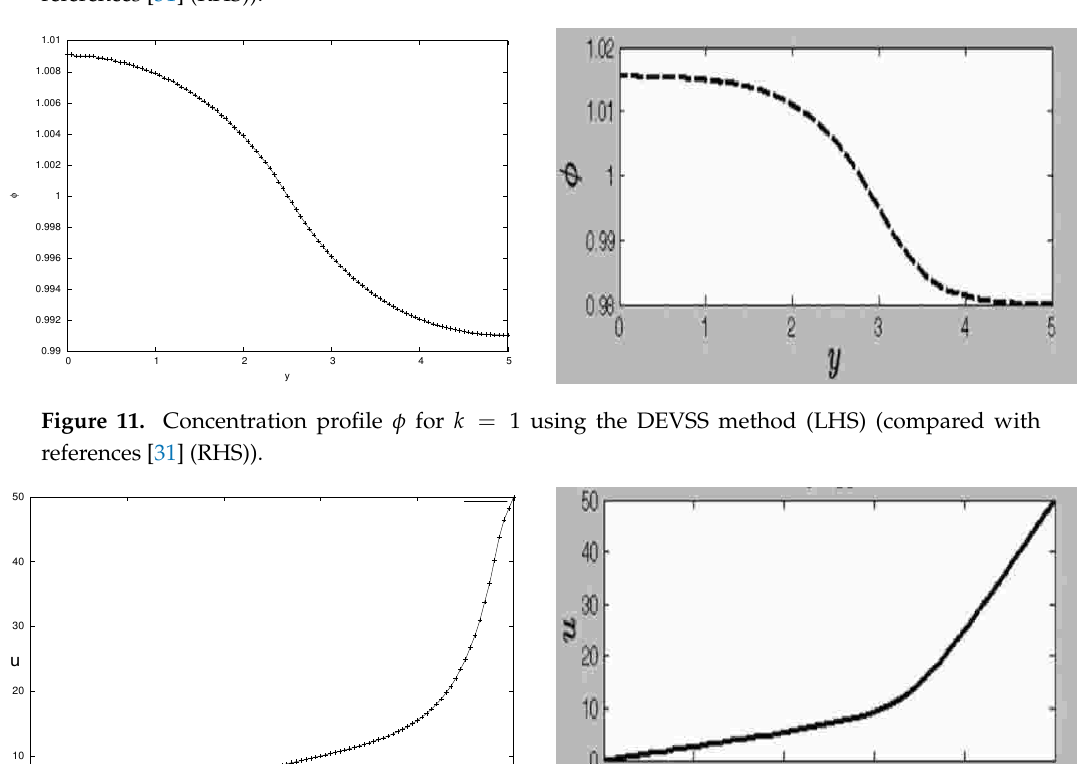
Figure 10. Concentration profile φ for k = 1 using the LCR method (LHS) (compared with references [31] (RHS)).